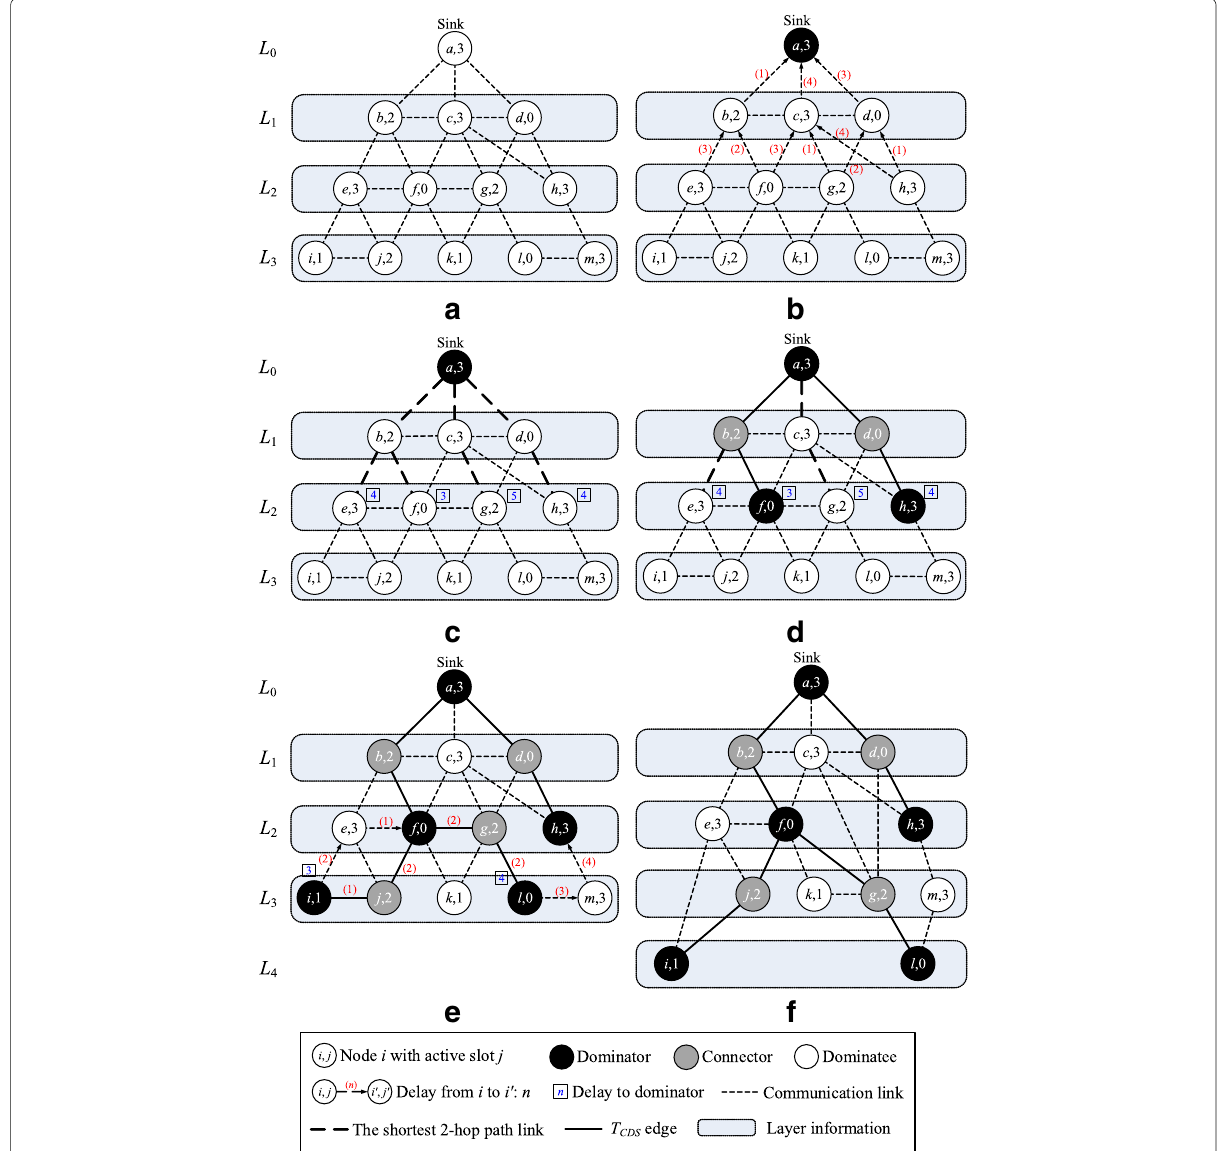
Fig. 2 An example of delay-aware tree construction. a Step 1: constructing layered structure. b Step 2 in L 2 : calculating delay from candidate dominator to upper dominators. c Step 2 in L 2 : finding the shortest path in terms of delay. d Step 3 in L 2 : adding dominators and connectors to